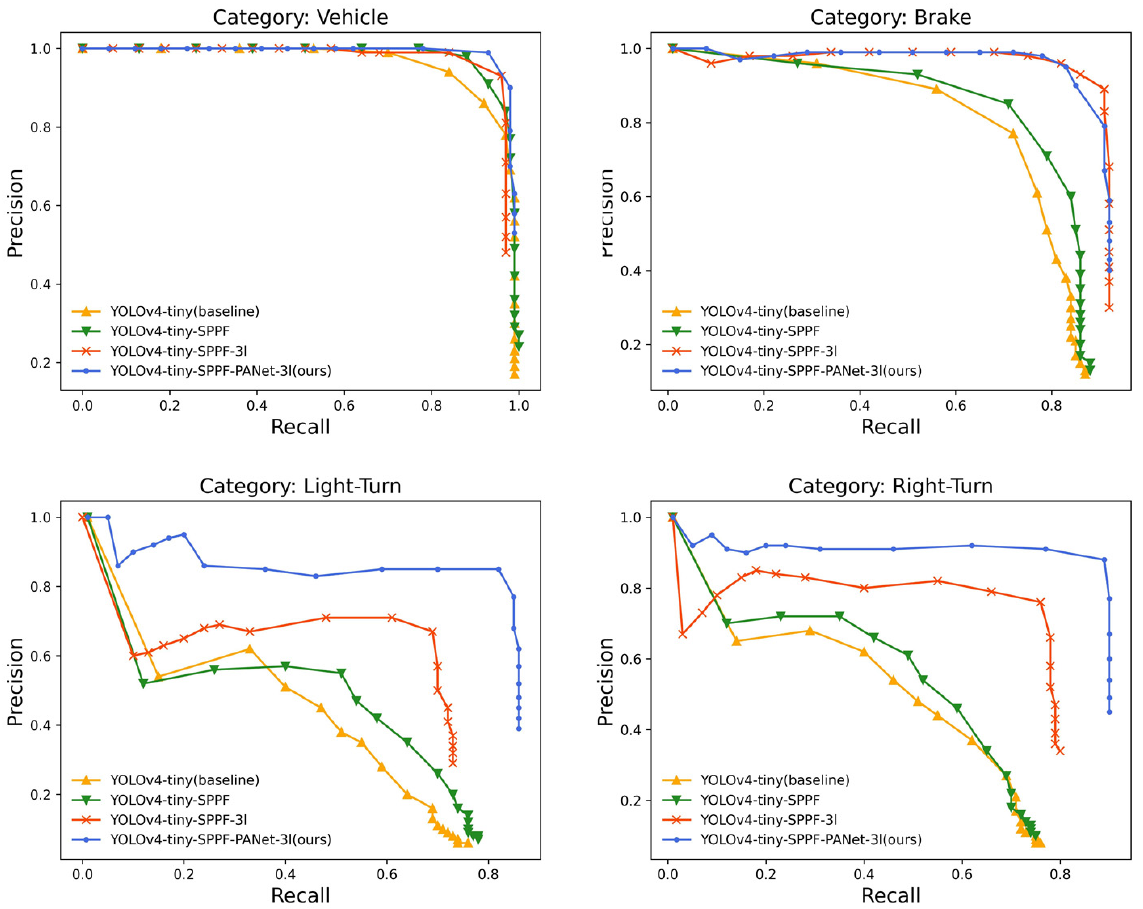
Figure 6. PR curves of four categories. YOLOv4-tiny [22] is chosen as the baseline.